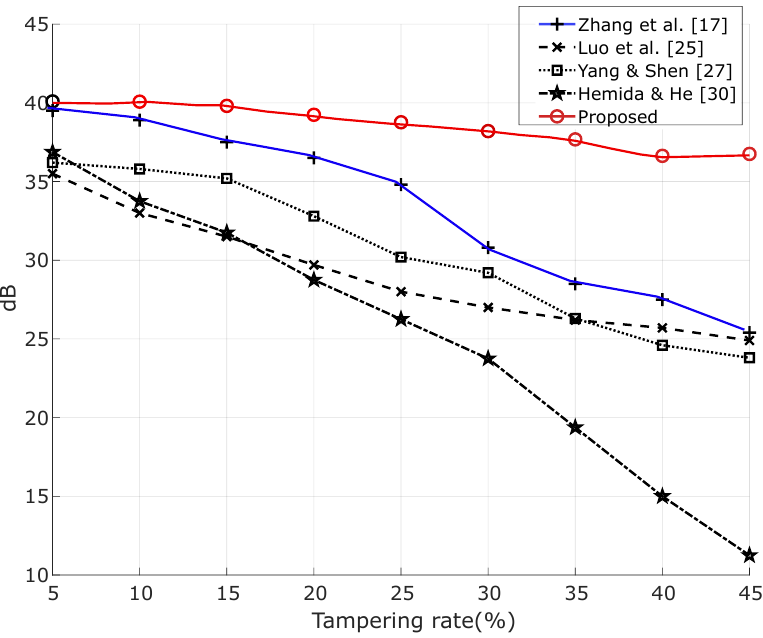
Figure 7. Comparison of the performance between previous methods and our proposed